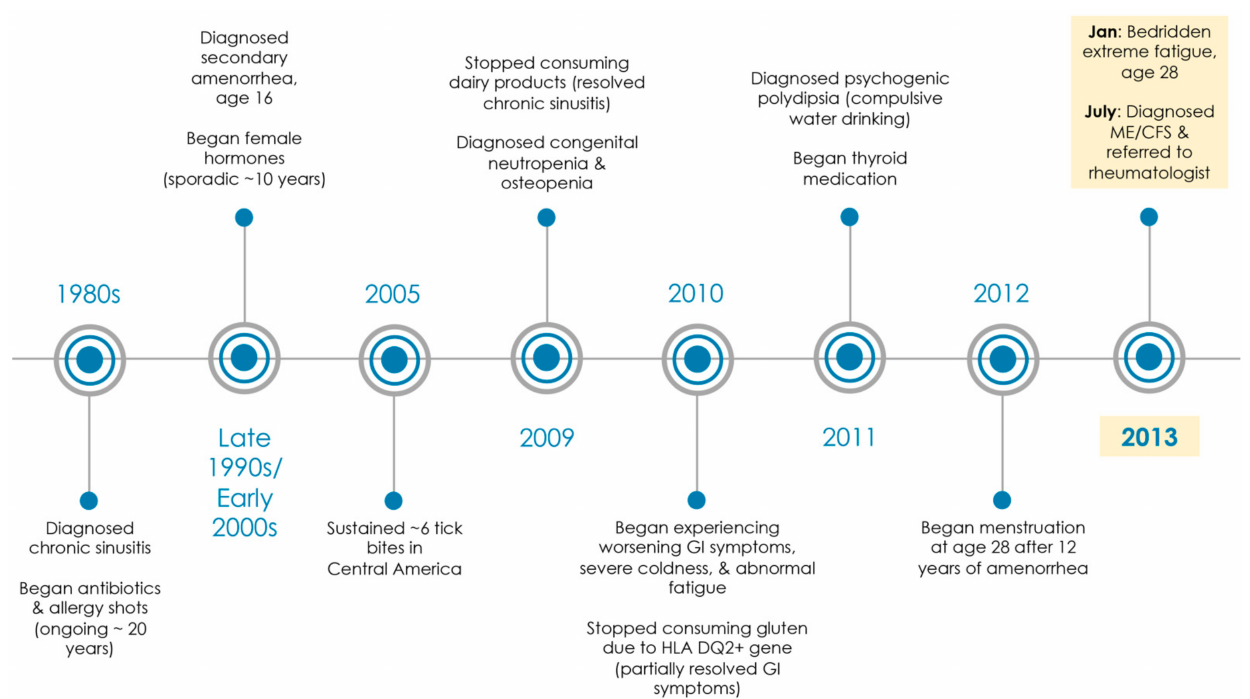
Figure 1. Medical history timeline. Patient saw over 20 medical specialists (i.e., pediatrics, allergy and immunology, gynecology, gastroenterology, endocrinology, hematology, infectious disease, internal medicine, alternative medicine, urgent care, and family medicine) from 1980s through 2013. In 2013, she was diagnosed with ME/CFS at age 28 by a family medicine physician and referred to a rheumatologist (MD,